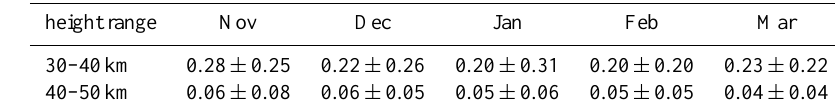
Table 2. Monthly mean GWPED per volume [Jm − 3 ] and standard deviation for different altitude intervals. The number of measurement days comprising the mean value are the same as in Fig. 3.